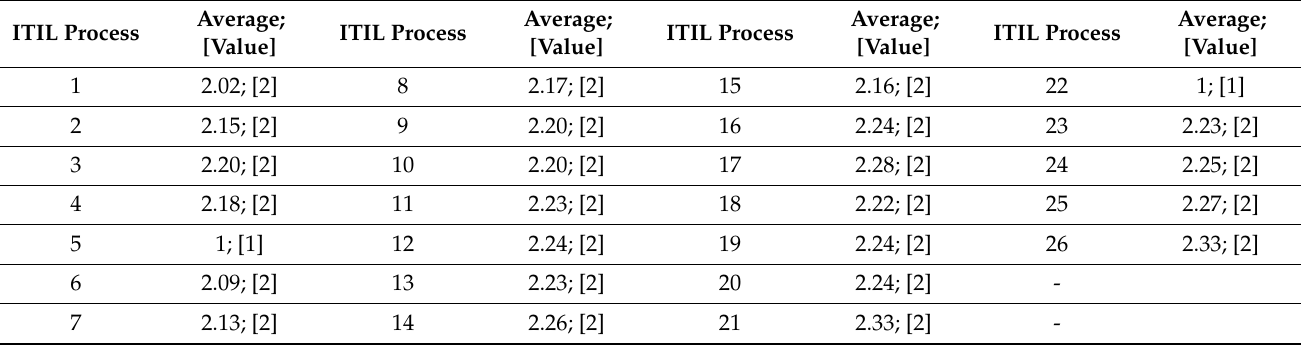
Table A2. Values used for ITIL processes in a representative company.